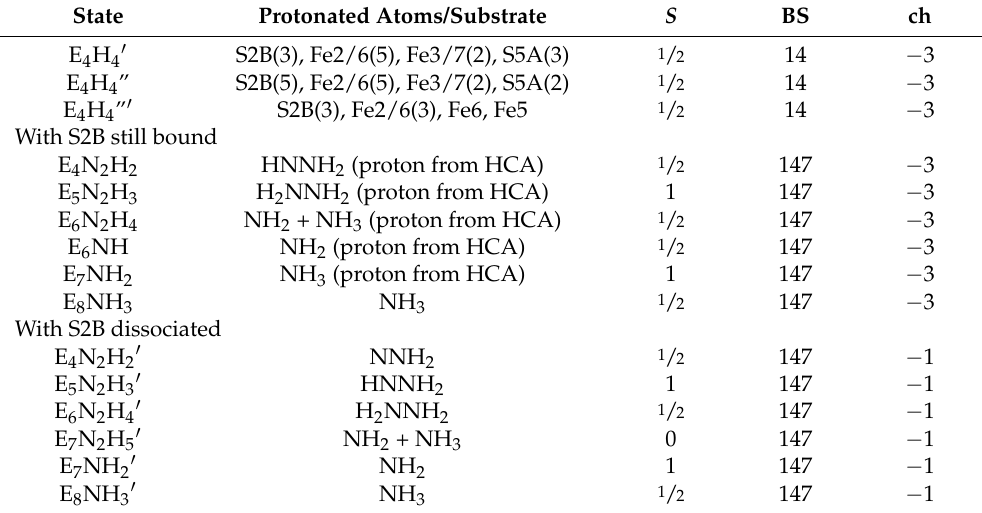
Table 5. Cont. State